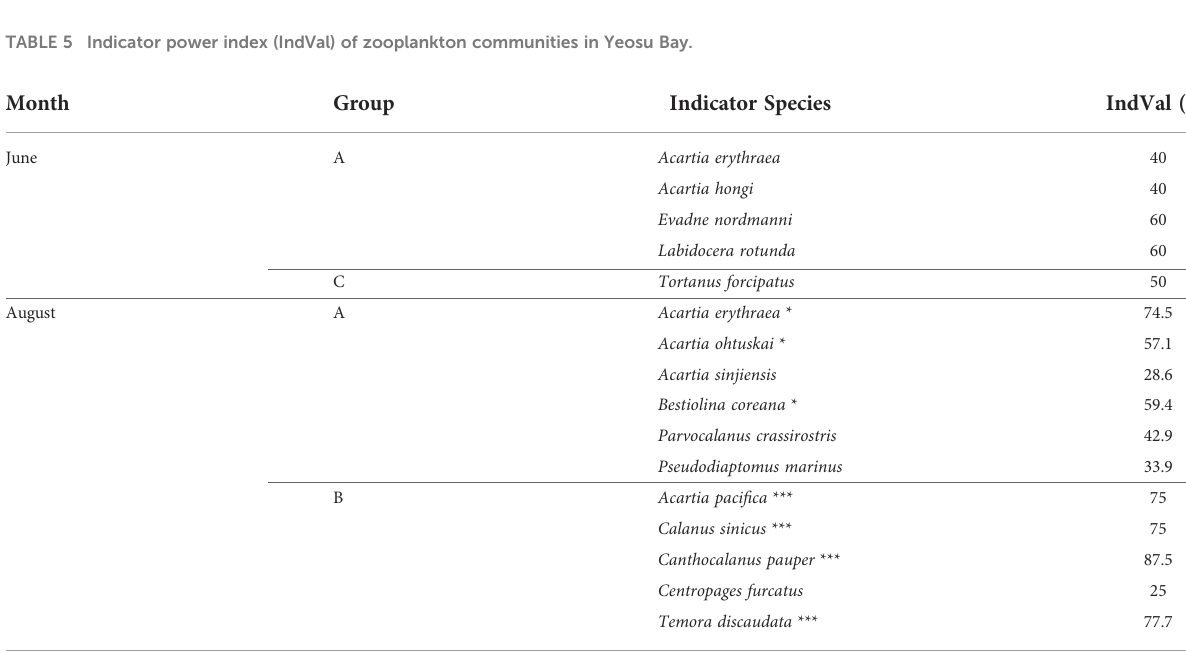
Asterisks indicate that the correlation is statistically signi fi cant (*p<0.05; **p<0.01; ***p<0.001).